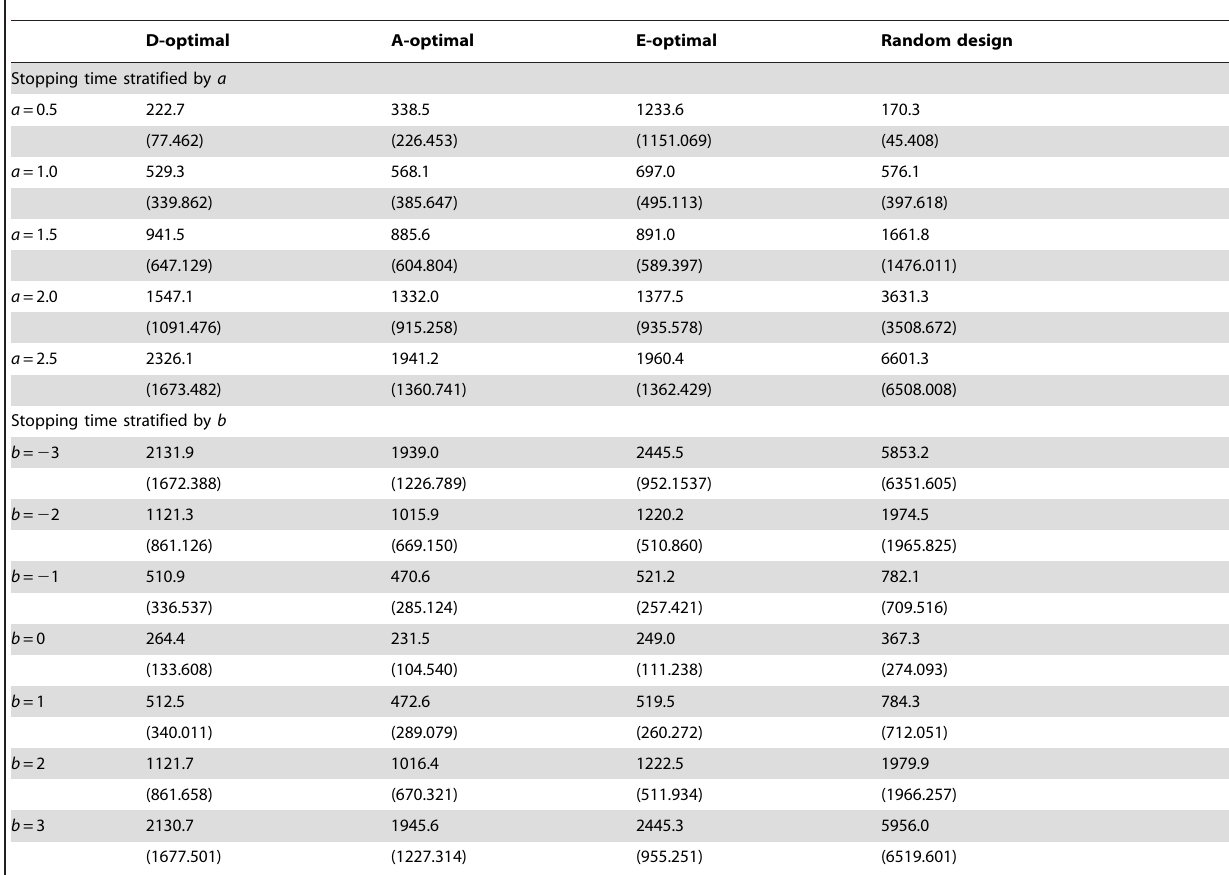
Table 4. Stopping time (sample size) of